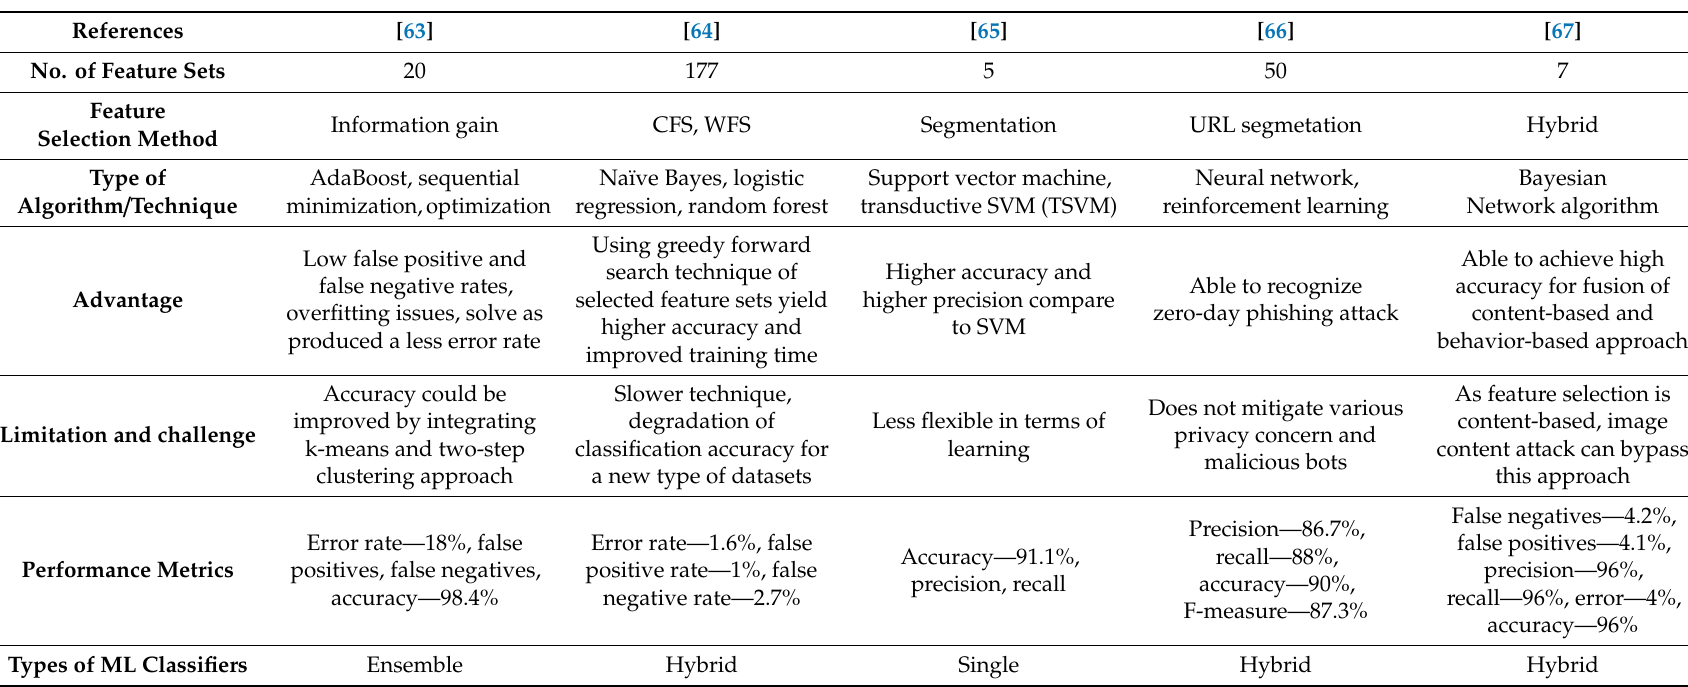
Table 5. Analysis of phishing detection techniques (notations: feature extraction and reduction, CFS- correlation-based feature selection, WFS- Wrapper Feature